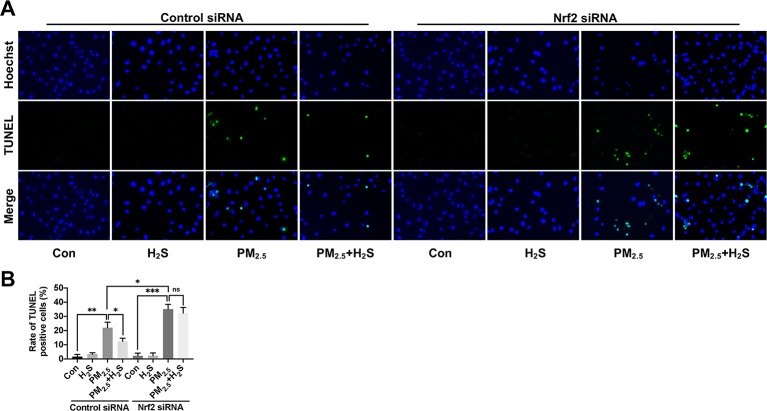
Effect of H2S on A549 cells apoptosis after PM2.5 exposure using terminal deoxynucleotidyl transferase deoxyuridine triphosphate nick-end labeling (TUNEL) assay. (A) Representative fluorescent images of Hoechst (blue), TUNEL (green), and merge in control, H2S, PM2.5, PM2.5+H2S group in control small interfering RNA (siRNA) or Nrf2 siRNA transfected A549 cells respectively (×400). (B) Percentage of TUNEL positive cells in each group respectively. Results are expressed as mean ± SD; three independent experiments were done in each group. ns p > 0.05, *p< 0.05, **p < 0.01, ***p < 0.001 between groups. Nrf2, nuclear factor erythroid 2 related factor 2; H2S, hydrogen sulfide; PM2.5, fine particulate matter.